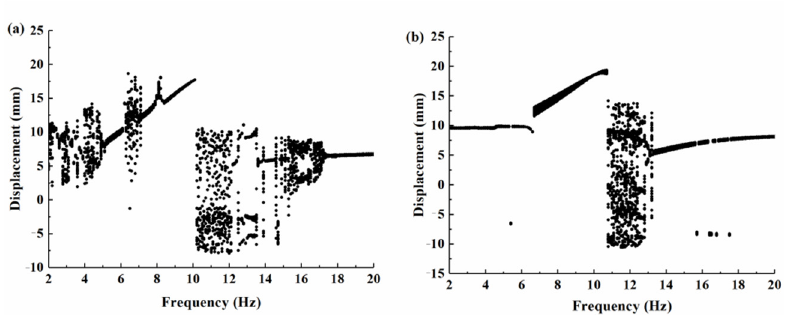
Figure 8. Bifurcation diagram of the tip displacement versus the excitation frequency for excitation amplitude A = 10 m/s 2 : ( a ) BPEH-V; ( b ) CBH-C.